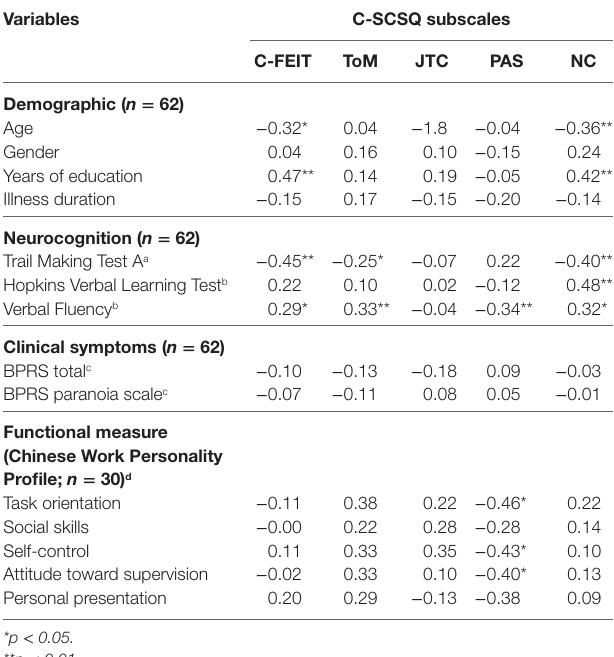
( Table 4 ). As with our expectation, the non-psychiatric controls had significantly higher scores for ToM ( t = − 3.89, p < 0.001,